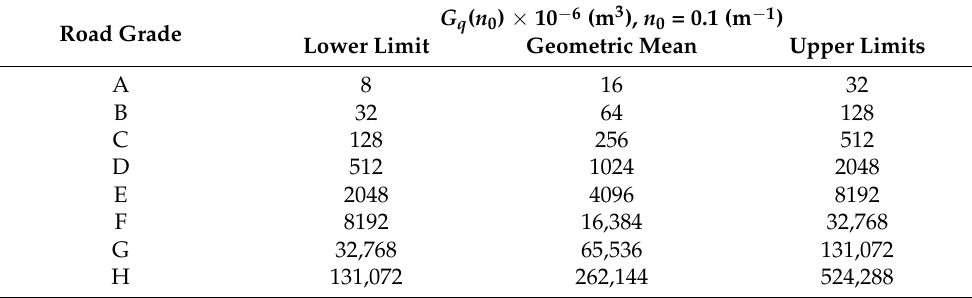
Table 1. Eight different grades of typical road roughness. Road